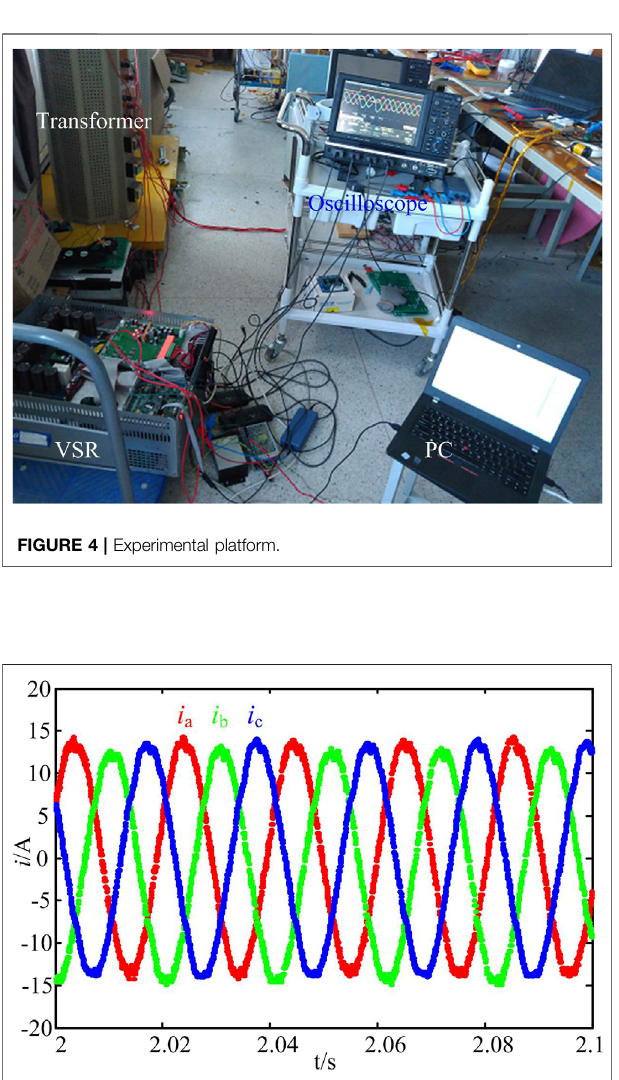
FIGURE 5 | Three-phase current data under normal